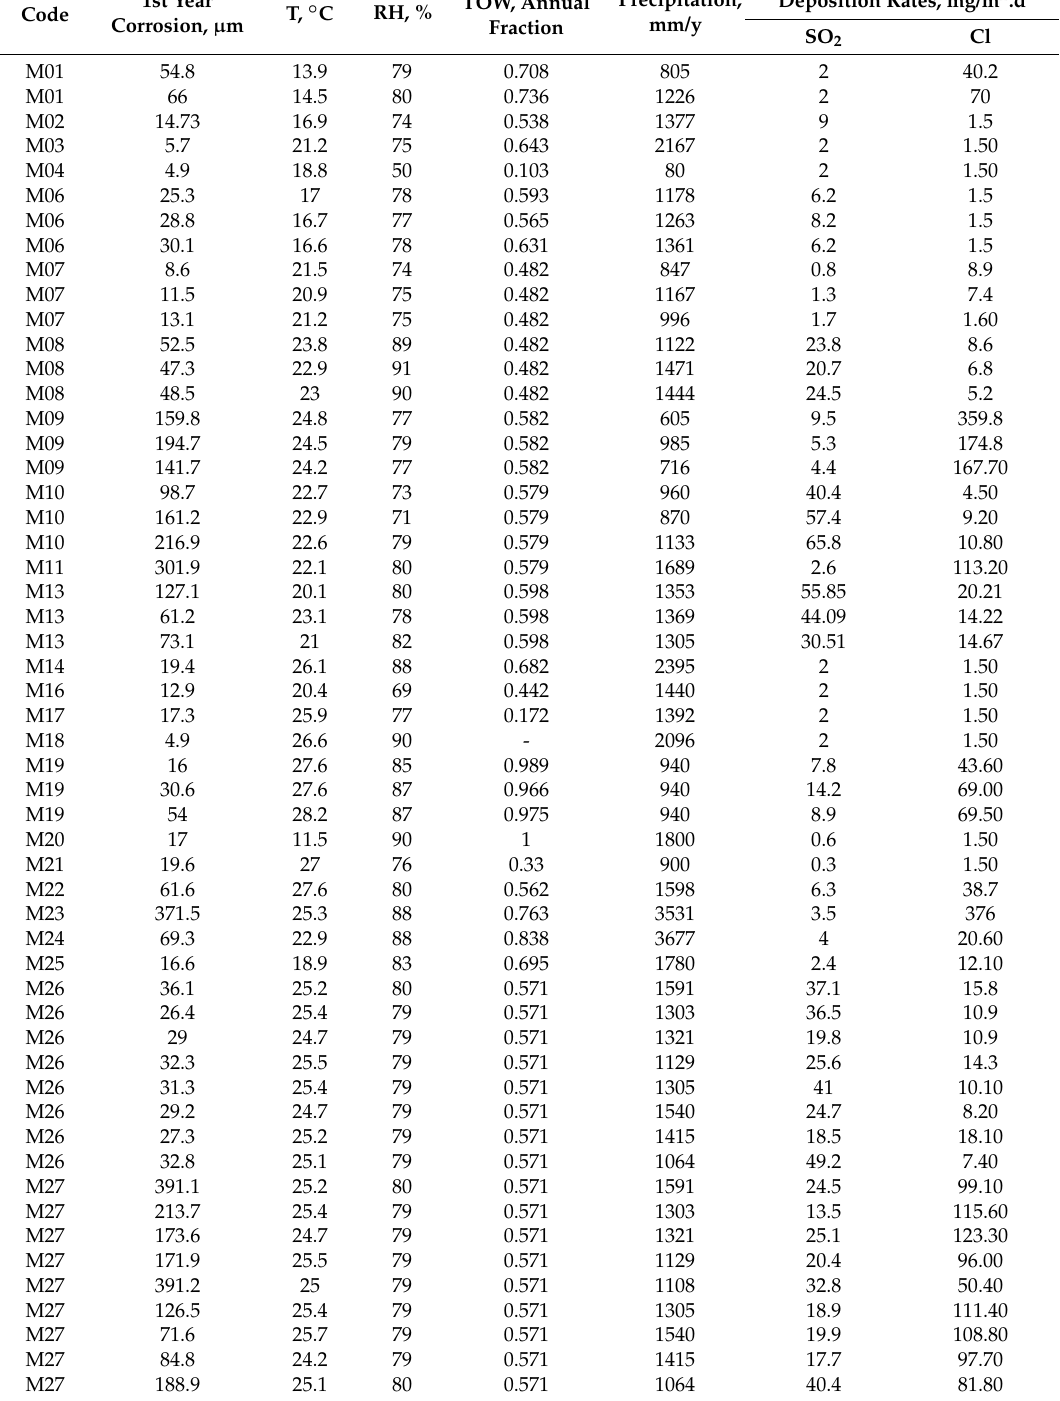
Table 6. MICAT data considered in the